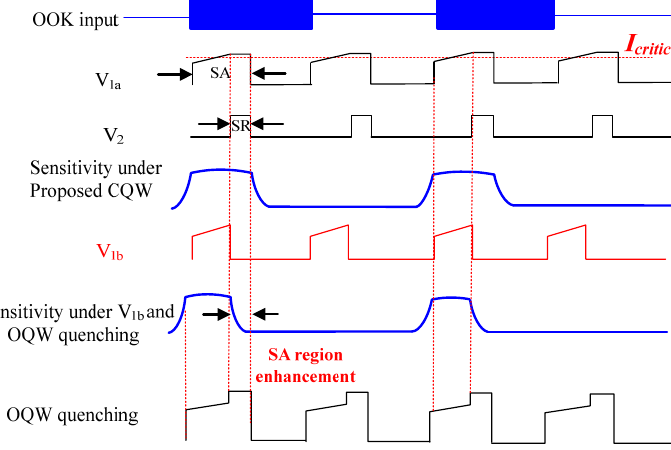
Figure 11. Comparison between the conventional OQW and the proposed CQW techniques.